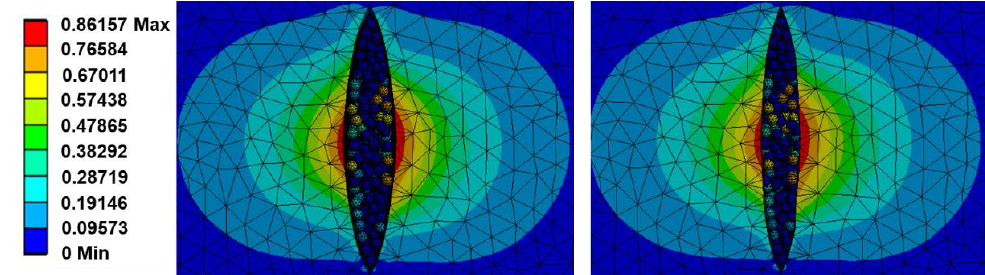
Figure 11. The undeformed and deformed assembly (2x deformation).